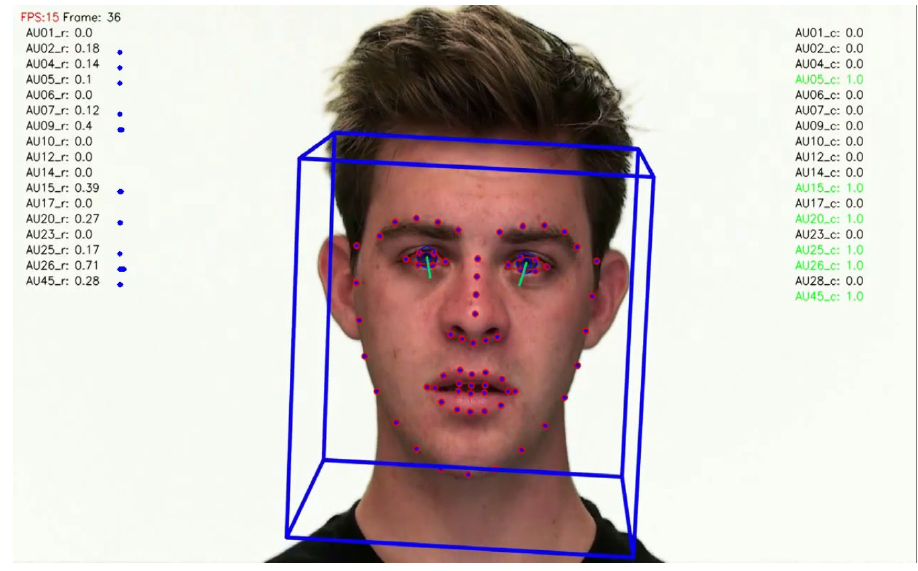
Figure 9. Facial recognition example 1.